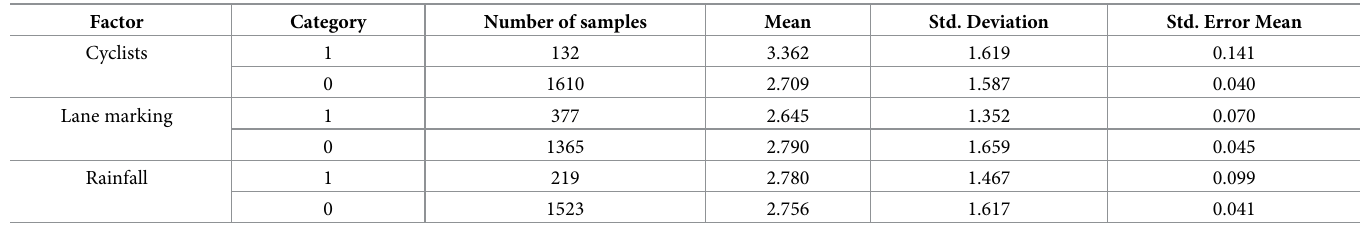
Table 1. Statistical mean of the saturation headway.